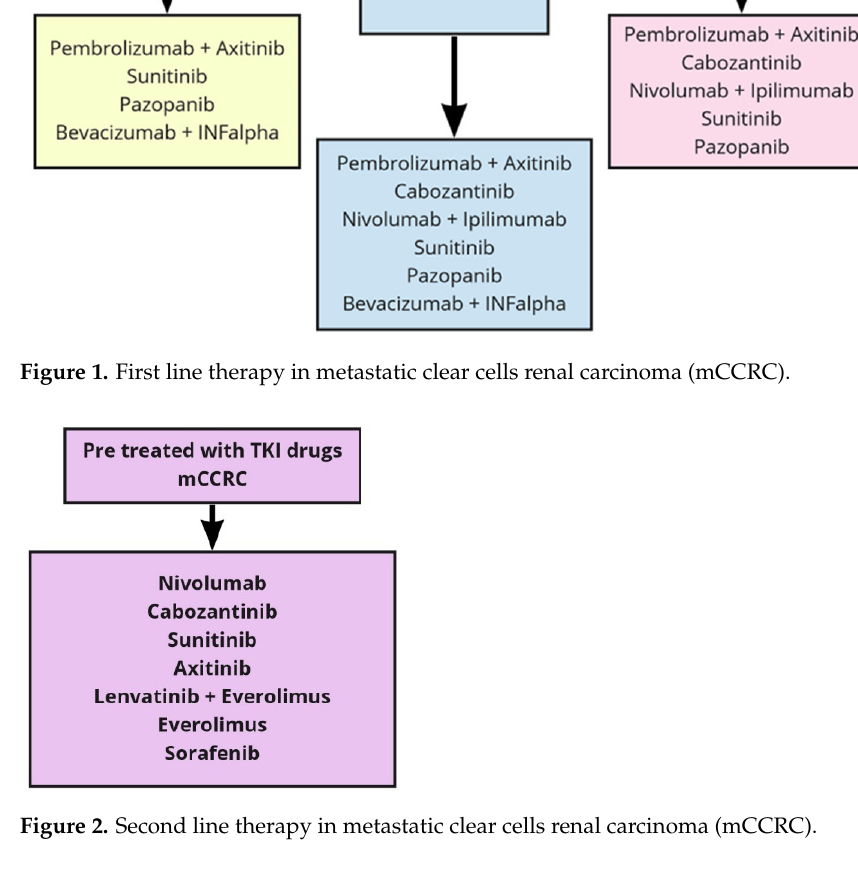
Figure 2. Second line therapy in metastatic clear cells renal carcinoma (mCCRC).